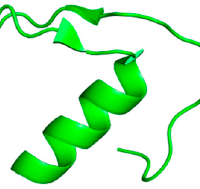
Figure 2. The solution structure of ShSPI (NMR ensemble) from the RCSB Protein Data Bank (PDB-ID: 6LF5) [12,16].